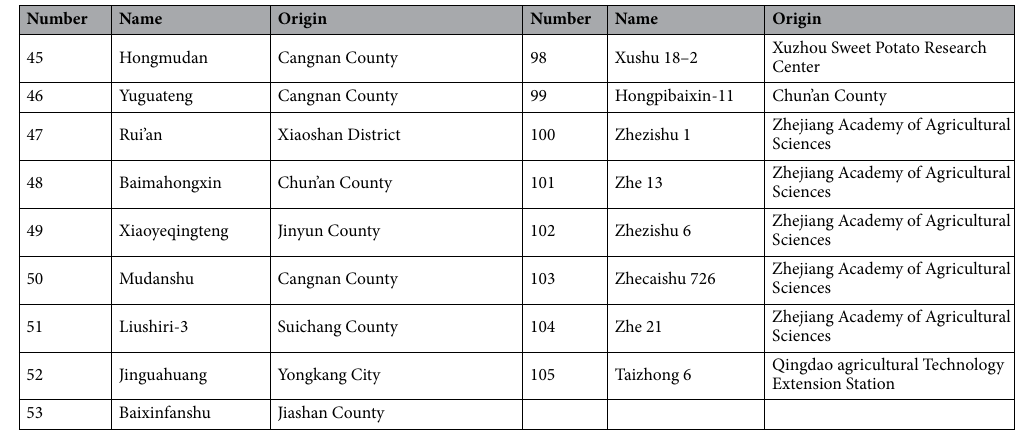
Table 2. The 105 sweet potato germplasms used in this study and their origins.